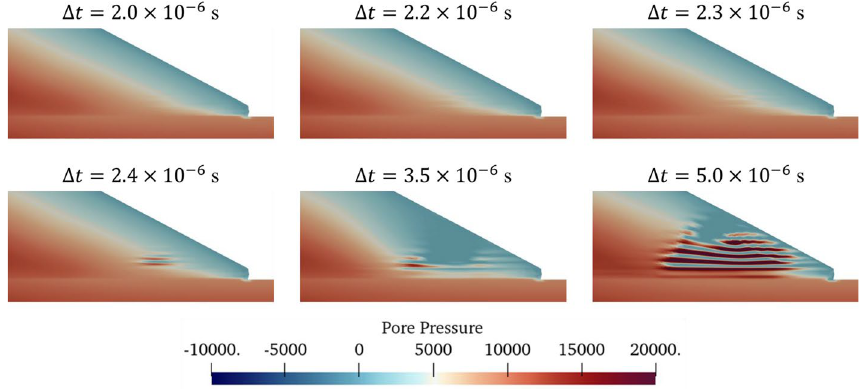
Fig. 19 Pore pressure distribution at t